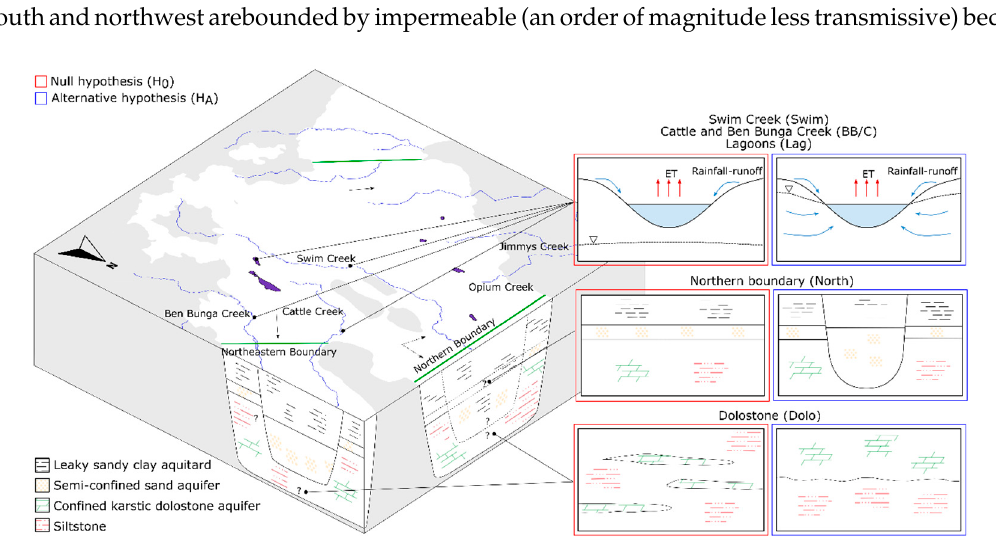
Figure 3. Conceptually uncertain components in Wildman River area and hypotheses developed to characterize the conceptual uncertainty.